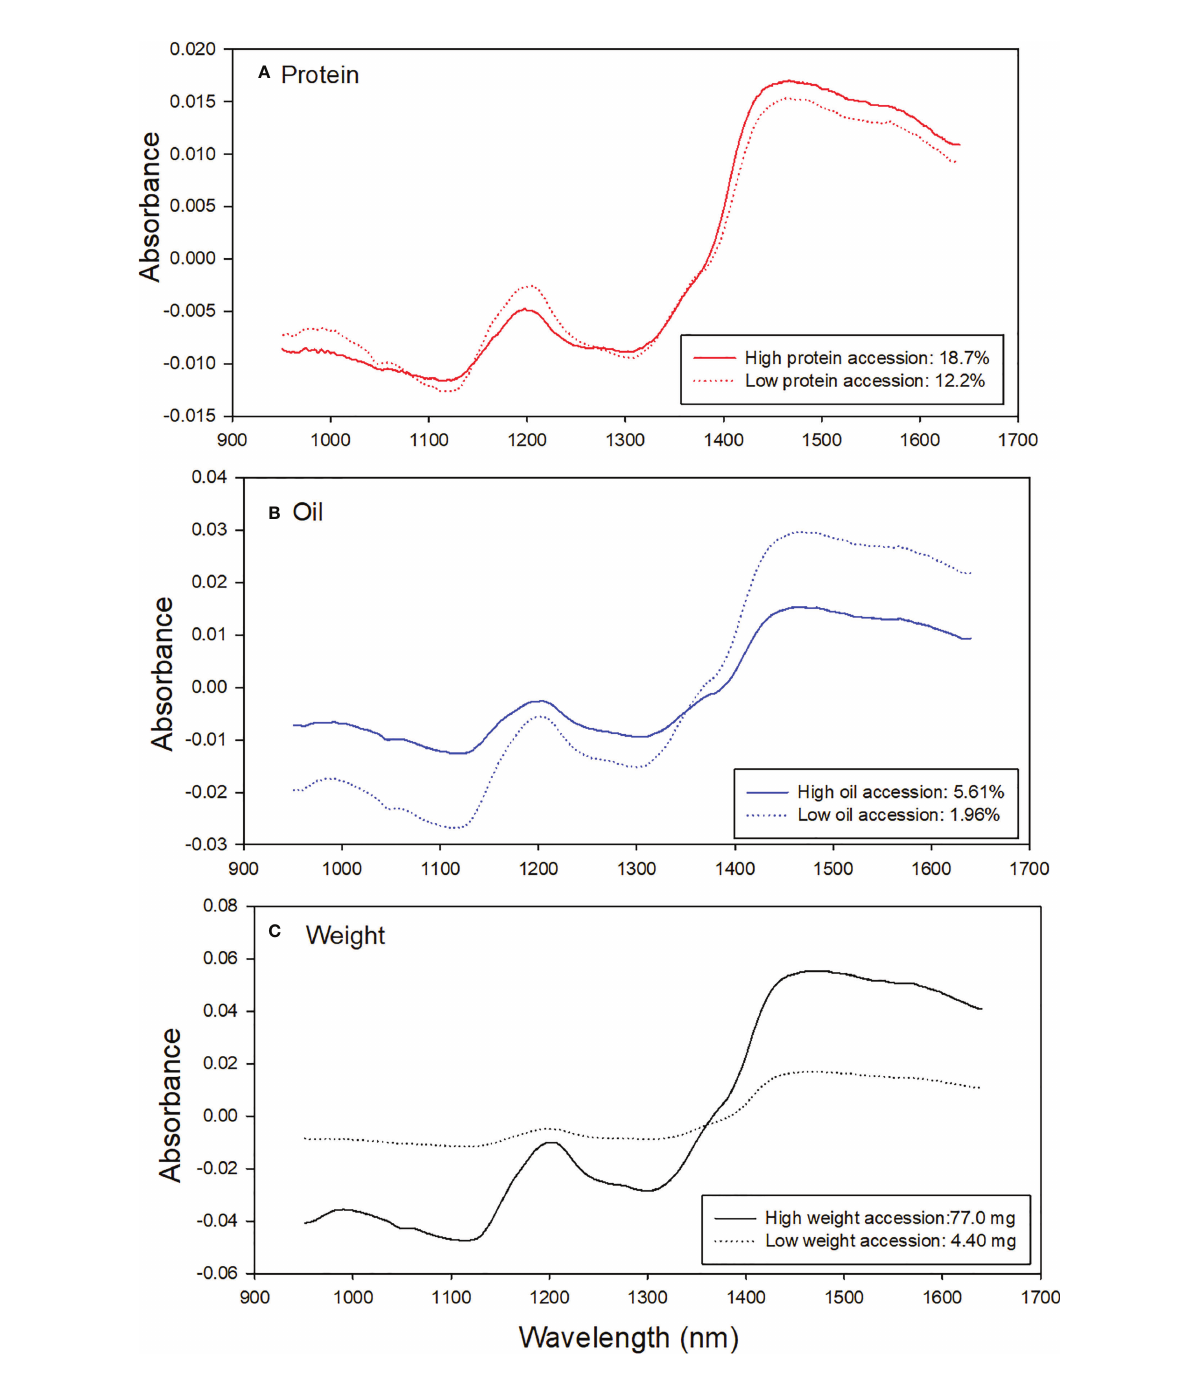
FIGURE 2 Frequency distribution for (A) protein, (B) Oil, and (C) weight for the sorghum